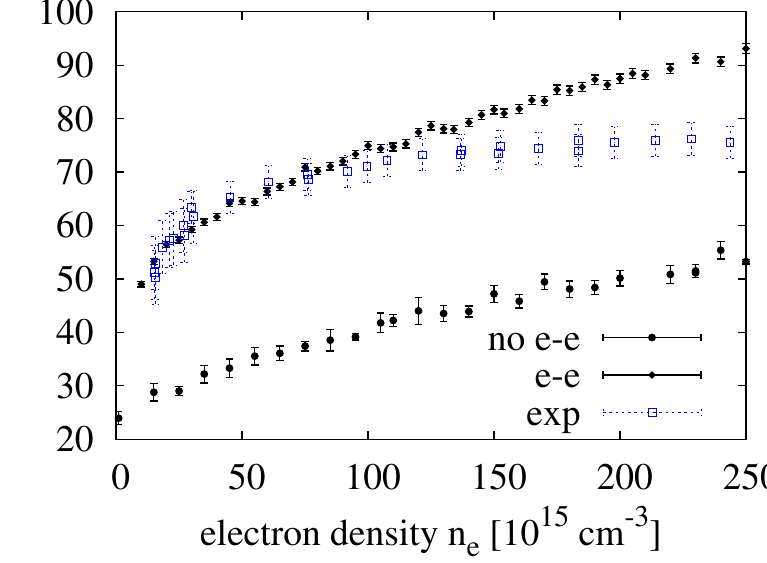
vs. electronic density calculated with and without electron-electron Figure 5. Results for τ s = 21 . 9 eV ˚A 3 . The experimental data interaction. Here: N = 25 × 10 3 , T = 300 K and γ so from [4] are plotted, as well (empty square